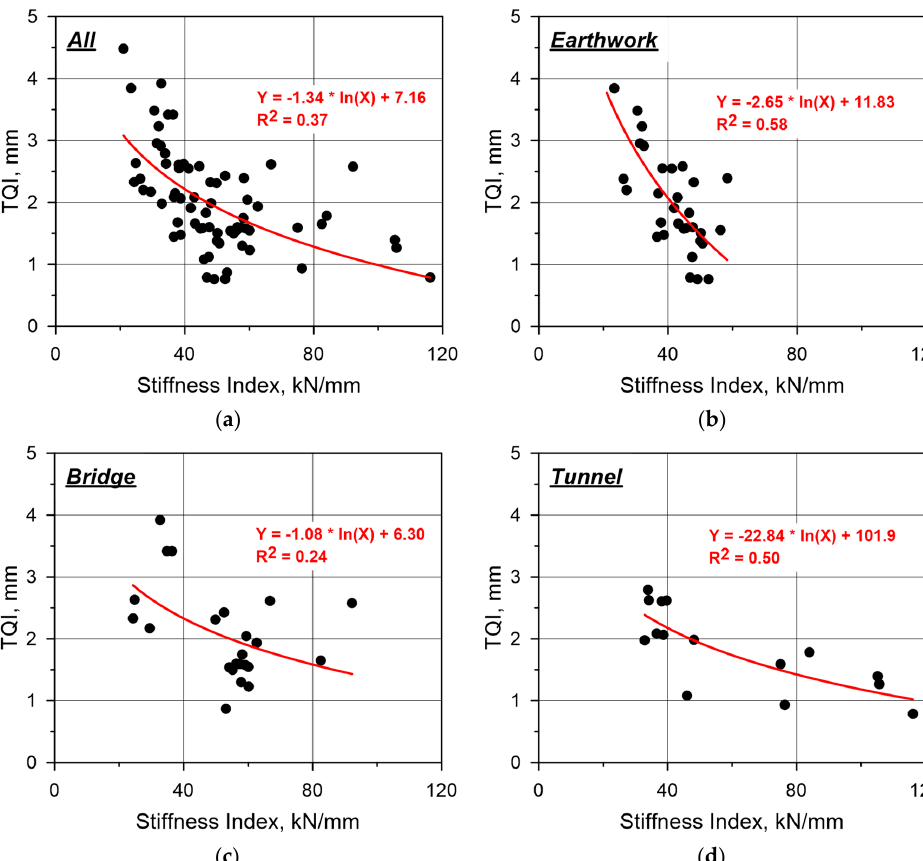
Figure 8. Track stiffness index ( α = 0.6) versus TQI: ( a ) All; ( b ) Earthwork; ( c ) Bridge; ( d )Tunnel.